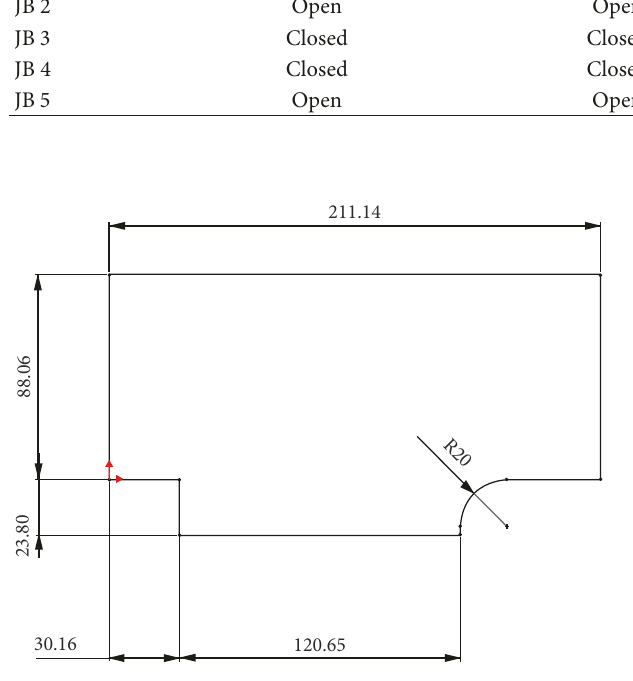
Figure 24: Cavity geometry with a curved trailing edge.